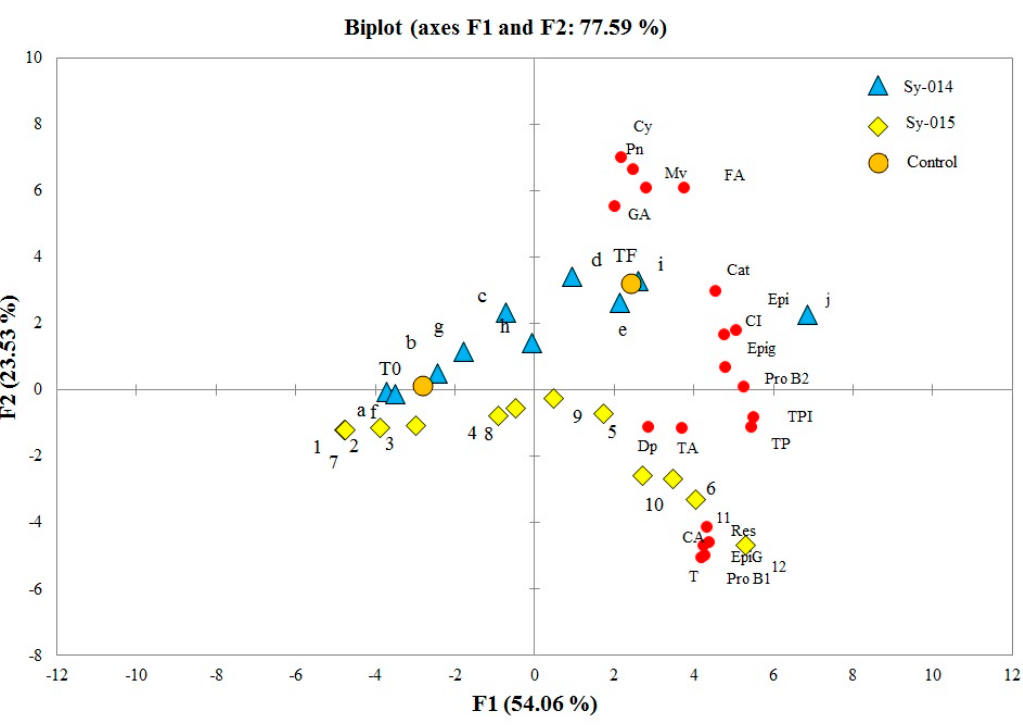
Figure 3. Biplot of the two first principal components obtained from the color and phenolic composition of the 2014 and 2015 Syrah grape harvest years : TA, total anthocyanin content; CI, color intensity; TPI, total polyphenol index; TP, total polyphenols; T, Tannins; Dp, delphinidin-3-O- glucoside ; Cy, cyanidin-3-O-glucoside ; Pn, peonidin-3-O-glucoside ; Mv, malvidin-3-O-glucoside